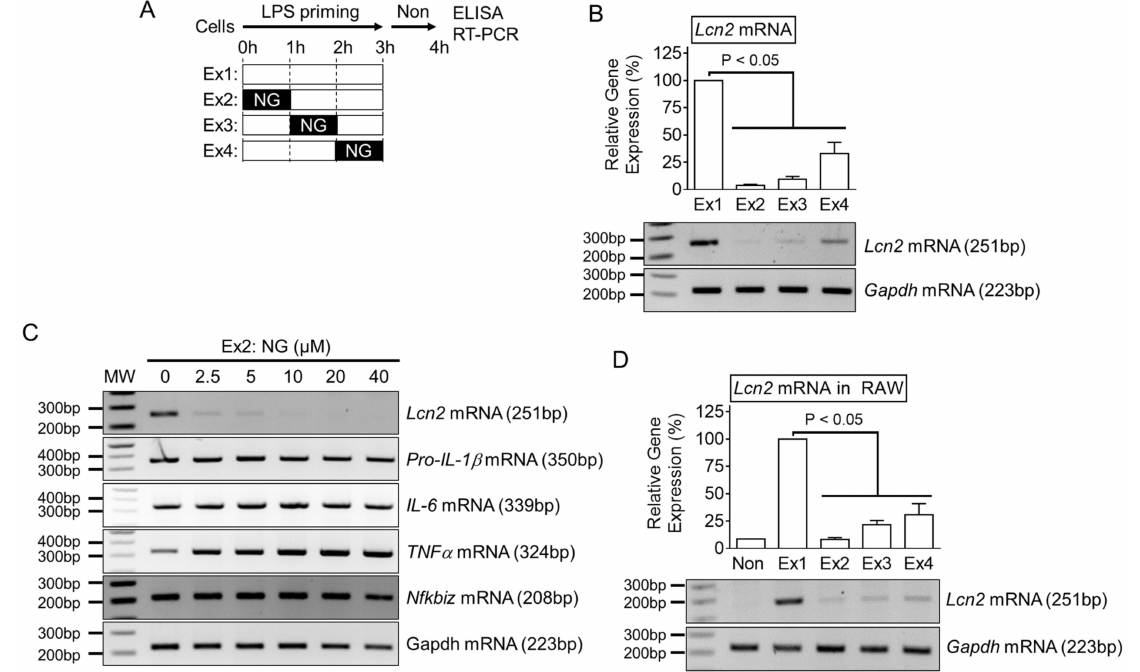
Figure 3. Effect of NG on Lcn2 transcription. ( A ) Schematic diagram of the experimental process. ( B ) BMDM were treated with LPS for three h in the presence of NG, as indicated in panel A. Lcn2 mRNA expression was analyzed by RT-PCR, and the band intensity is represented as a bar graph. ( C ) BMDM were treated with LPS and various dosages of NG, as indicated in Ex2 of panel A. Gene expression was analyzed by RT-PCR. ( D ) Raw 264.7 cells were treated with LPS and NG, as shown in panel A. Lcn2 gene expression was assayed by RT-PCR, and the band density is presented as the bar graphs. The bar graph shows the mean ± SD of at least two independent